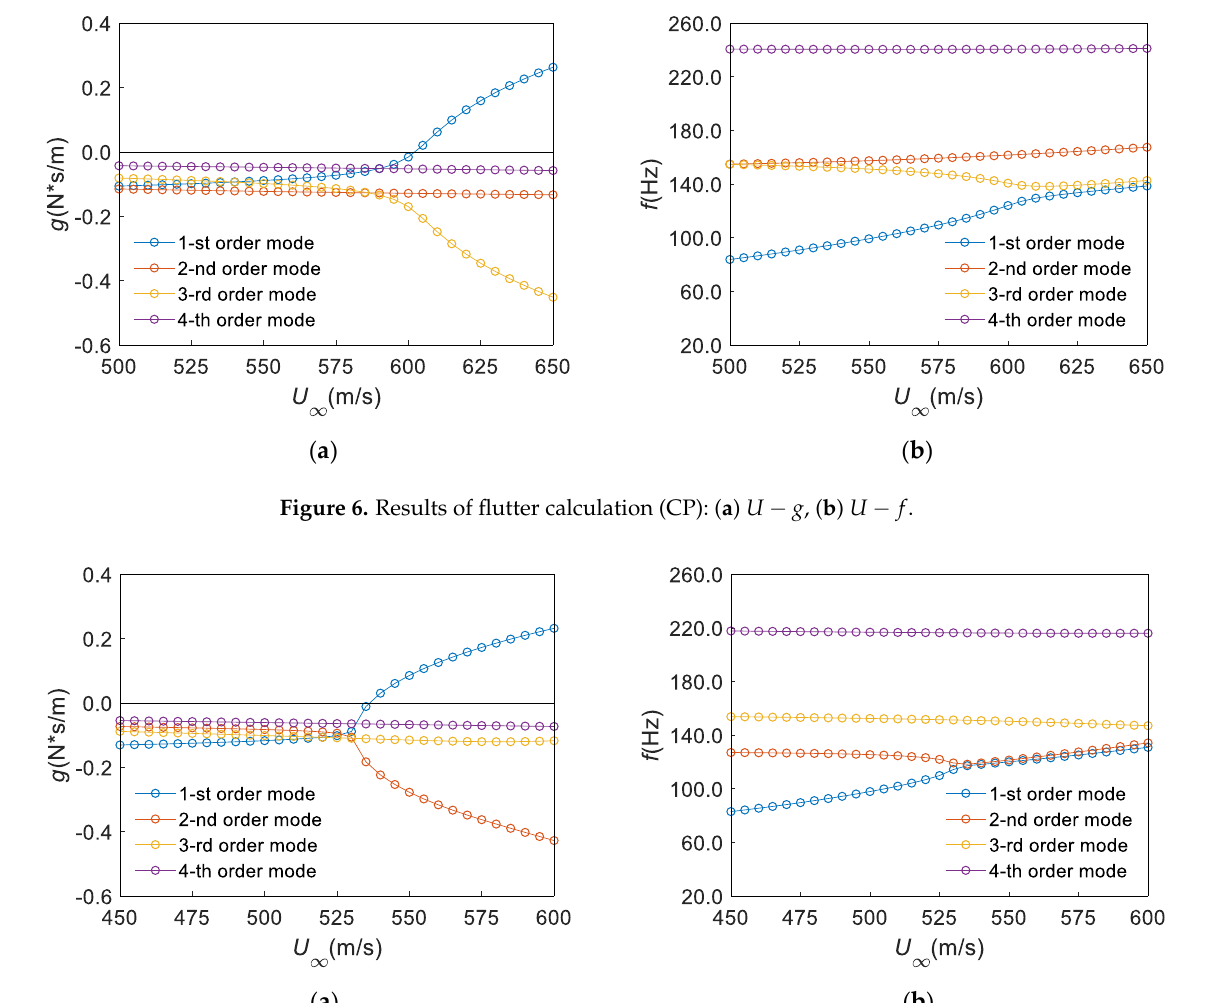
Figure 5. Two different positions of a mass attachment: ( a ) the center point of the panel (CP); ( b ) the intersection point located at 1/4 span length and 1/4 chord length (QP).